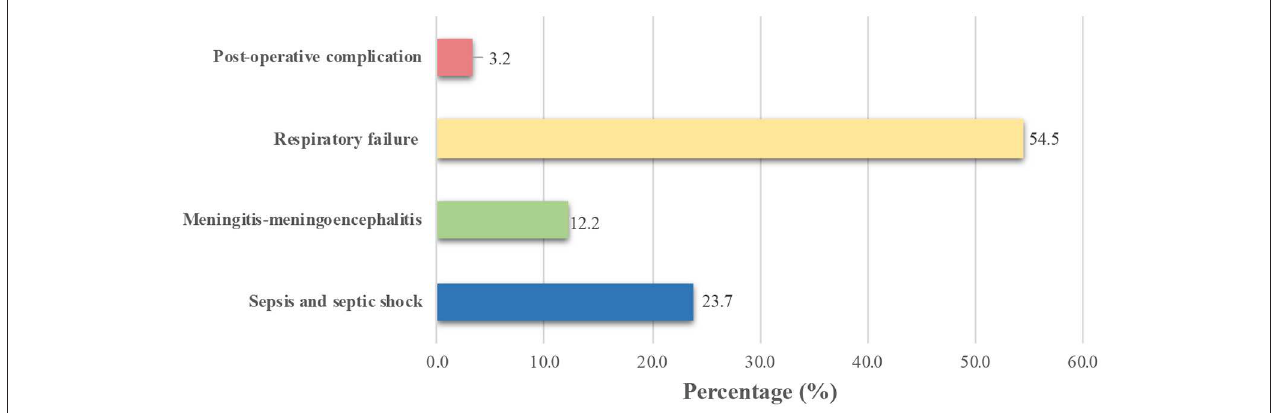
FIGURE 4 | Cause of death among confirmed COVID-19